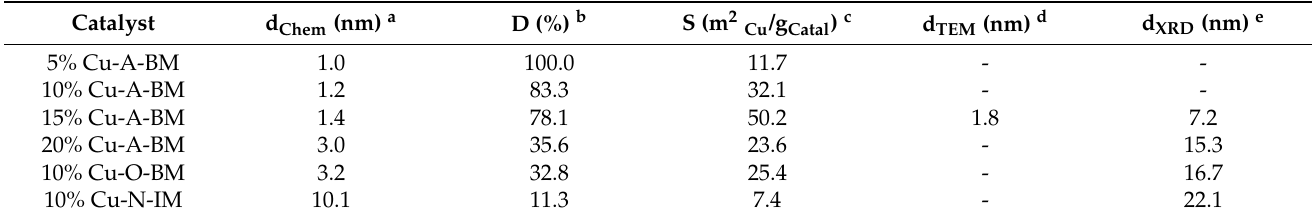
Table 4. Particle sizes measured by different methods, dispersion, and active area of all catalysts.